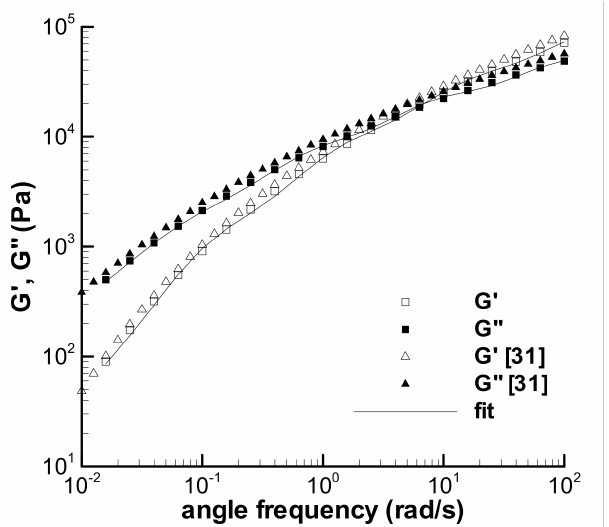
Figure 2. Dynamic frequency sweep experiments of the LDPE (Q200) melt at 150 ◦ C ( γ = 5%) and its